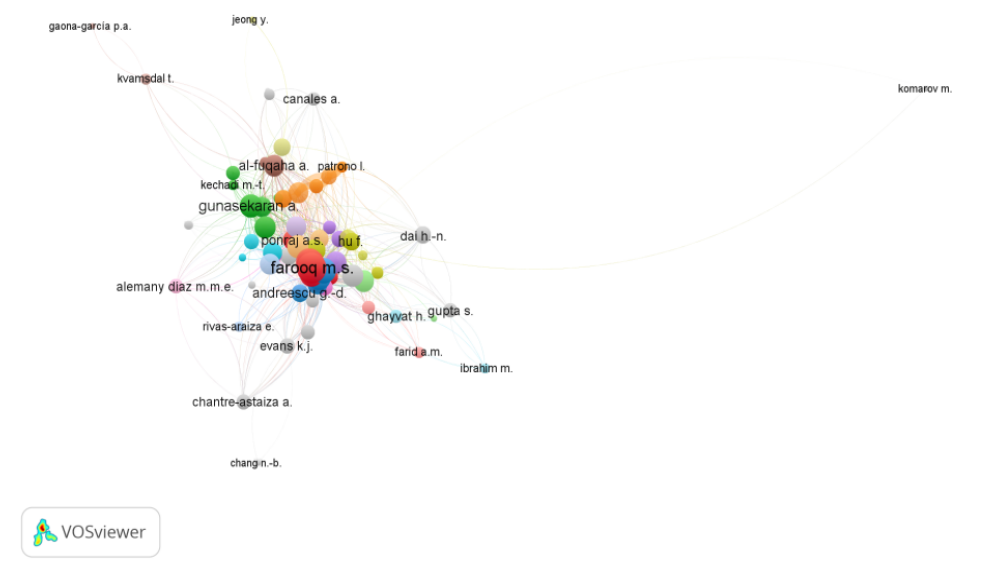
Figure 6. Network analysis of co-authors and authors based on co-appearance among the same